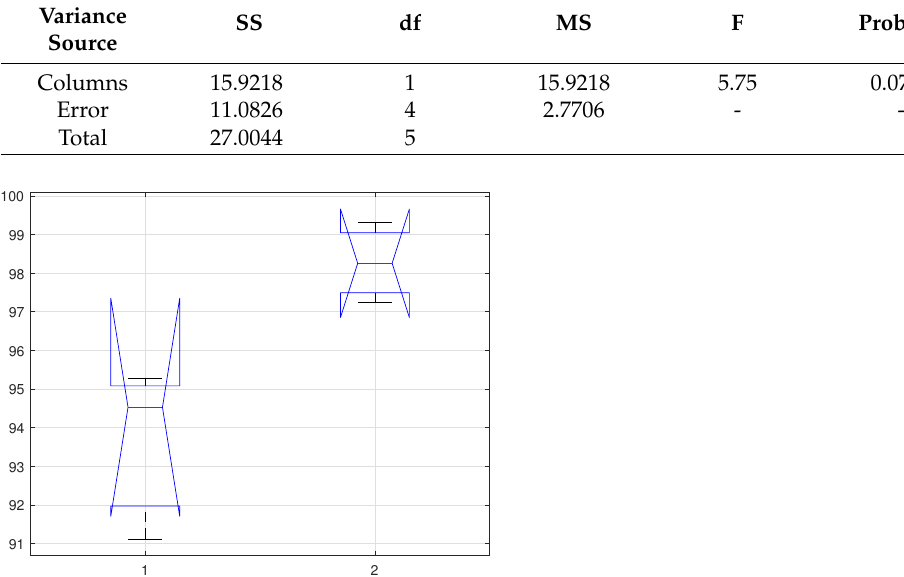
Figure 7. Confidence Interval of selected classifiers using statistical features of time-series data.